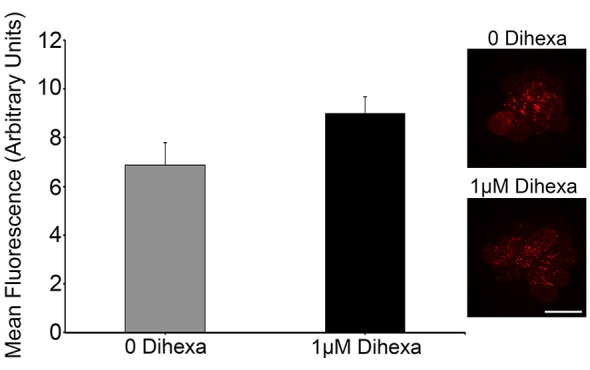
Dihexa does not block aminoglycoside entry into hair cells. There was no significant difference in quantified GTTR fluorescence within neuromasts of animals treated with or without 1 μM Dihexa (t-test; p = 0.1158). Sample control neuromast with bright GTTR fluorescence (inset top) is qualitatively the same intensity as a neuromast treated with 1 μM Dihexa (inset bottom). Scale bar represents 10 μm and applies to both images. N = 8 animals per treatment, error bars represent ± s.e.m.